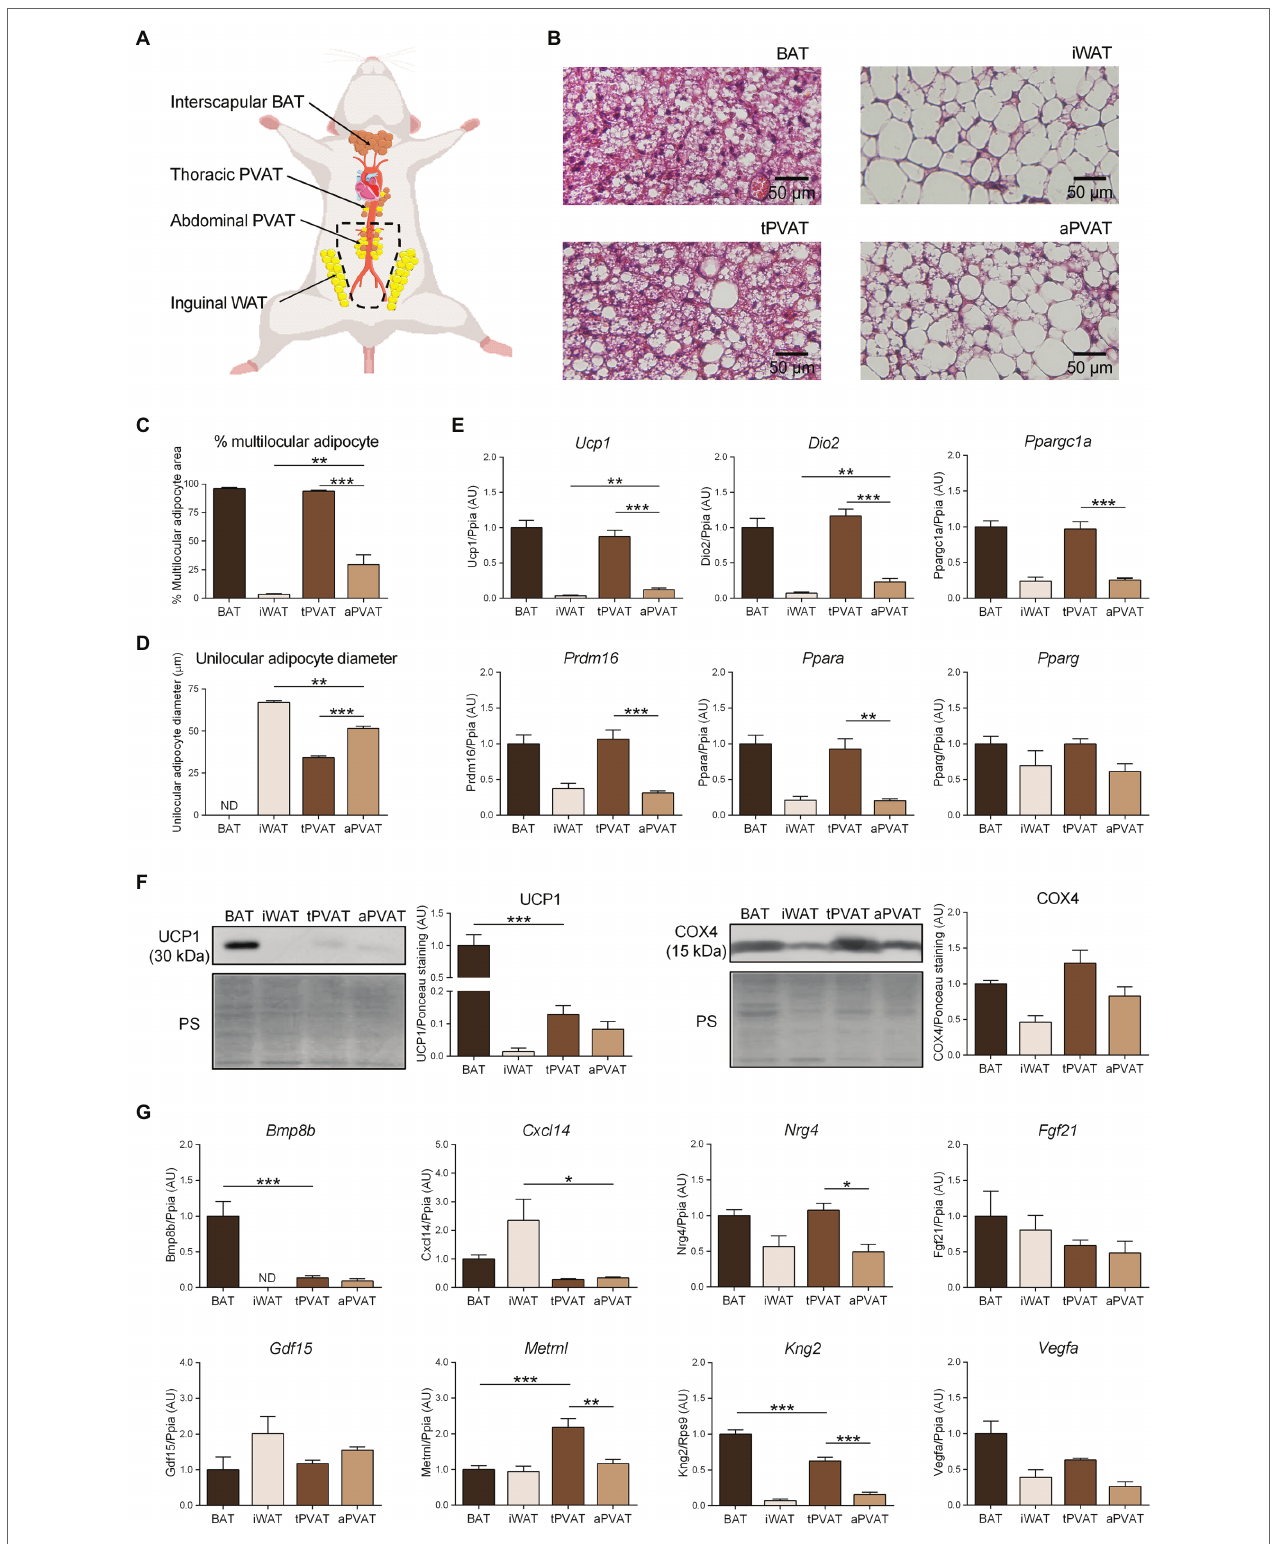
FIGURE 1 | Characterization of perivascular adipose depots in mice under basal conditions. (A) Schematic representation of the anatomical placement of interscapular brown adipose tissues (BAT), inguinal WAT (iWAT), thoracic PVAT (tPVAT), and abdominal PVAT (aPVAT) depots in mice. (B) Representative